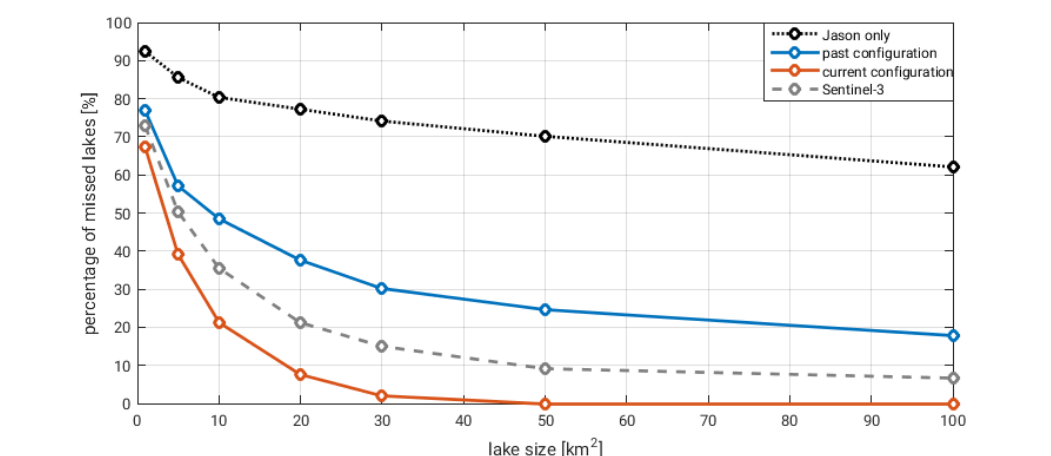
Figure 4. Percentage of missed lakes/reservoirs for different altimetry configurations depending on minimal target size (from 1 to 100 km 2 ) based on a water occurrence threshold of